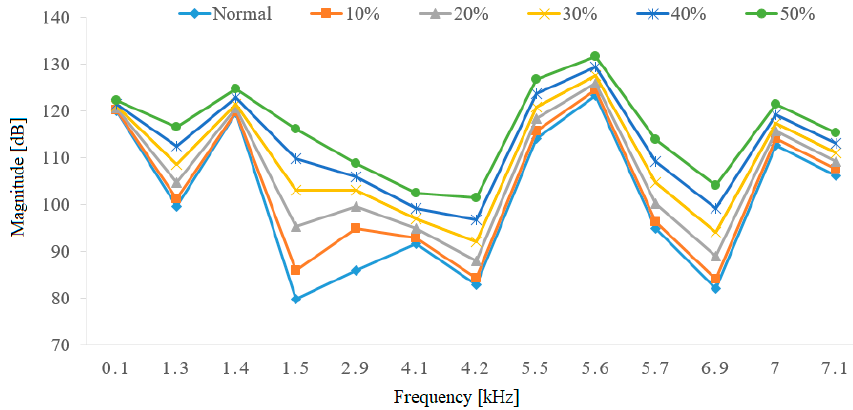
Figure 18. Different degree of static eccentricities on motor vibration response.